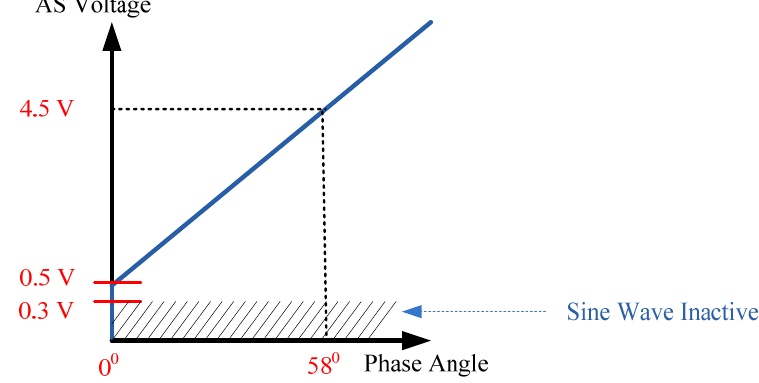
Figure 5. Phase angle correction for current leading.